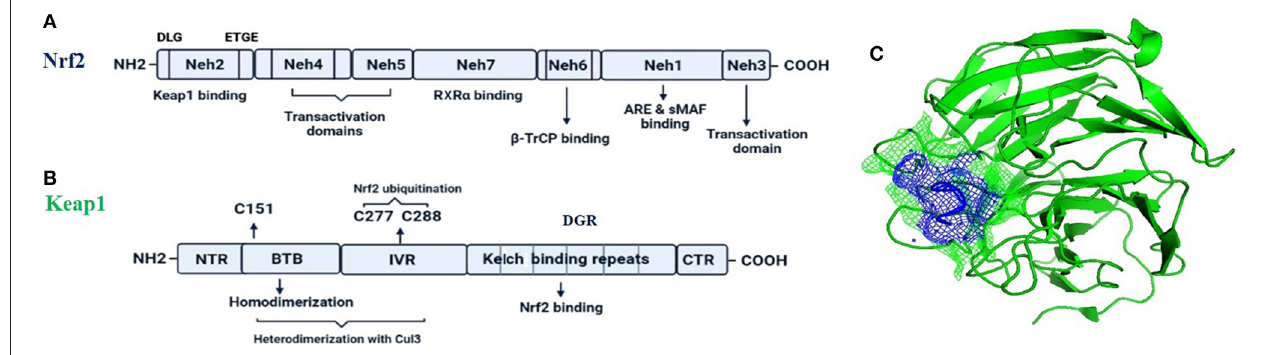
FIGURE 1 | The fundamental structures of Nrf2 (A) and Keap1 (B) . In (C) is reported a surface presentation of the N-terminal region of the Nrf2 (purple color in mesh) in complexed with the Keap1 protein (green color in carton) from crystal structures: 2DYH.